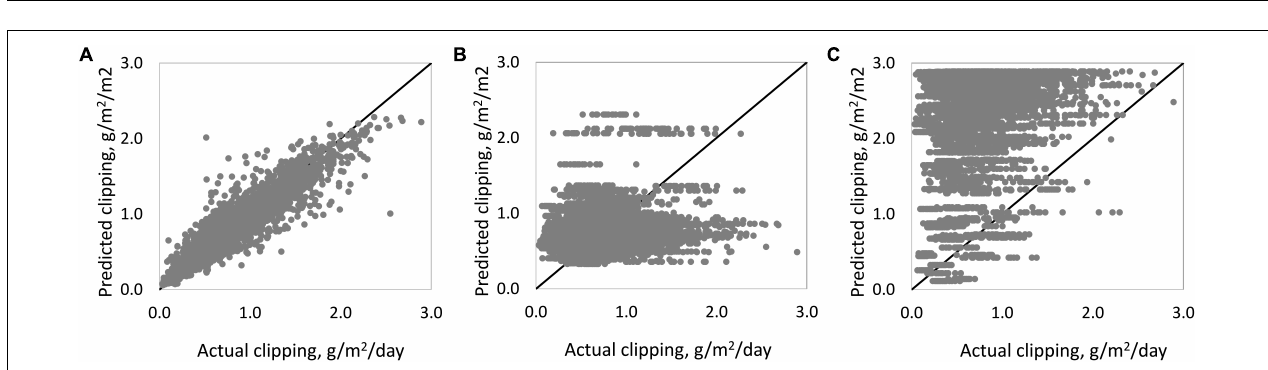
FIGURE 5 | The partial dependence of creeping bentgrass clipping production on the N application rate (A) ; average 3-day soil moisture content (B) ; the average temperature on the previous 3 days of clipping collection event (C) ; accumulative days that turf grew between mowing (D) ; normalized difference red edge (NDRE) (E) ; average relative humidity on the previous 4 days of clipping collection event (F) .